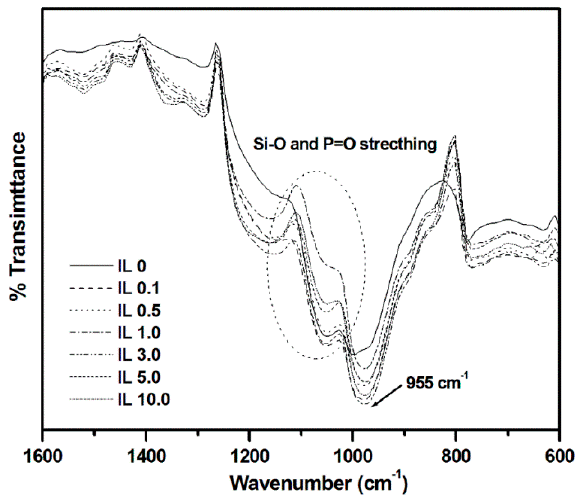
Figure 1. Expanded regions (600–1600 cm − 1 ) of FT-IR spectra for the wet silica ionogels. Table 2. TGA data of wet silica